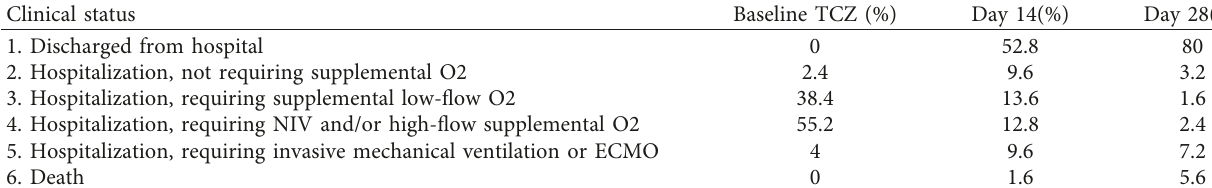
Table 3: Change in clinical status in patients with TCZ.